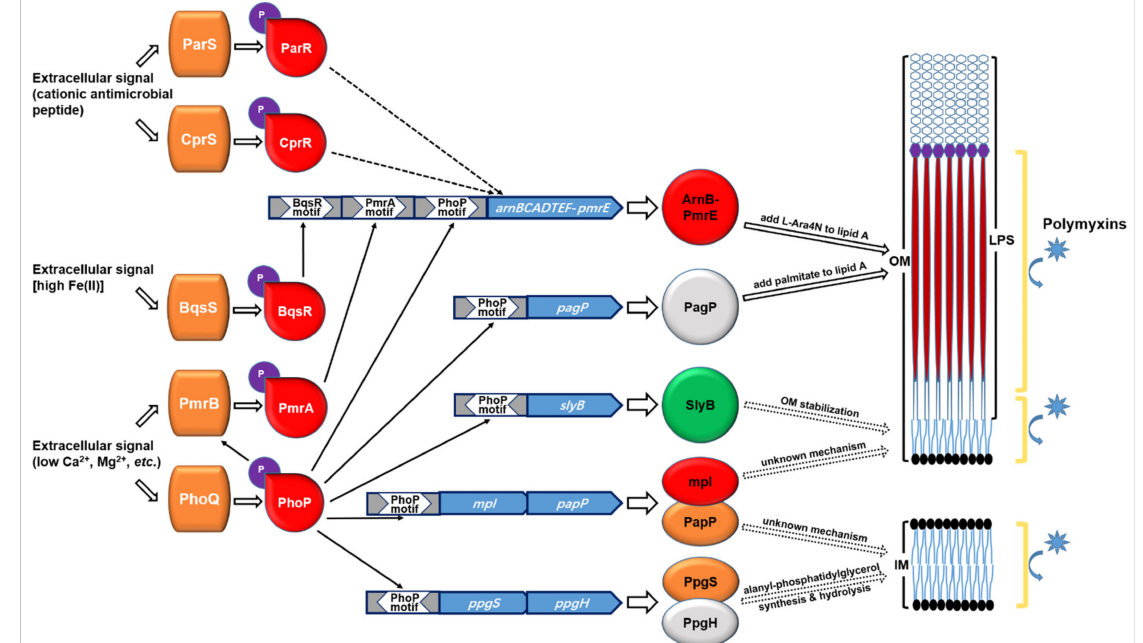
Figure 6. Schematic diagrams of PhoP-PhoQ regulated genes in the bacterial resistance to polymyxin B. The two-component regulatory systems PhoP-PhoQ and PmrA-PmrB are activated by depletion of divalent cations. Phosphorylated PmrA activates the transcription of arnBCADTEF-pmrE operon that contributes to bacterial resistance to polymyxins by adding L-Ara4N to lipid A (26). The two-component regulatory systems ParS-ParR and CprS-CprR activate expression of the arnBCADTEF-pmrE operon in response to cationic antimicrobial peptides [29]. Another two-component regulatory system BqsS-BqsR activates the expression of the arnBCADTEF-pmrE operon in response to Fe(II) [30]. Phosphorylated PhoP activates the expression of pmrA-pmrB and the arnBCADTEF-pmrE operon as well as pagP , mpl - papP , slyB , and ppgS - ppgH . The pagP reduces the affinity between LPS and polymyxins through addition of palmitate to lipid A. The papP and slyB protect bacterial outer membrane integrity. The mpl and ppgS - ppgH are involved in maintaining inner membrane integrity in response to polymyxins. Colors of the genes were adopted from the Pseudomonas Genome Database (www.pseudomonas.